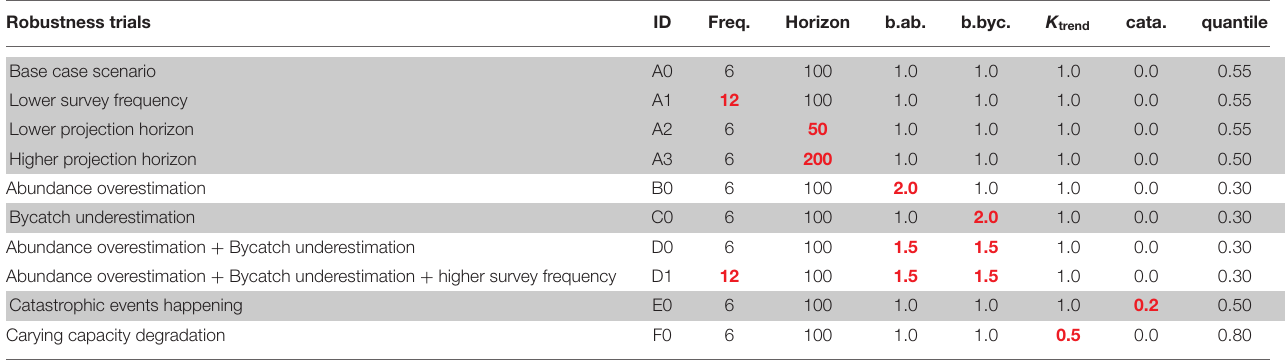
TABLE 4 | Summary of parameter combination for each robustness trial tested and the resulting quantile. Robustness trials ID Freq. Horizon b.ab. b.byc.